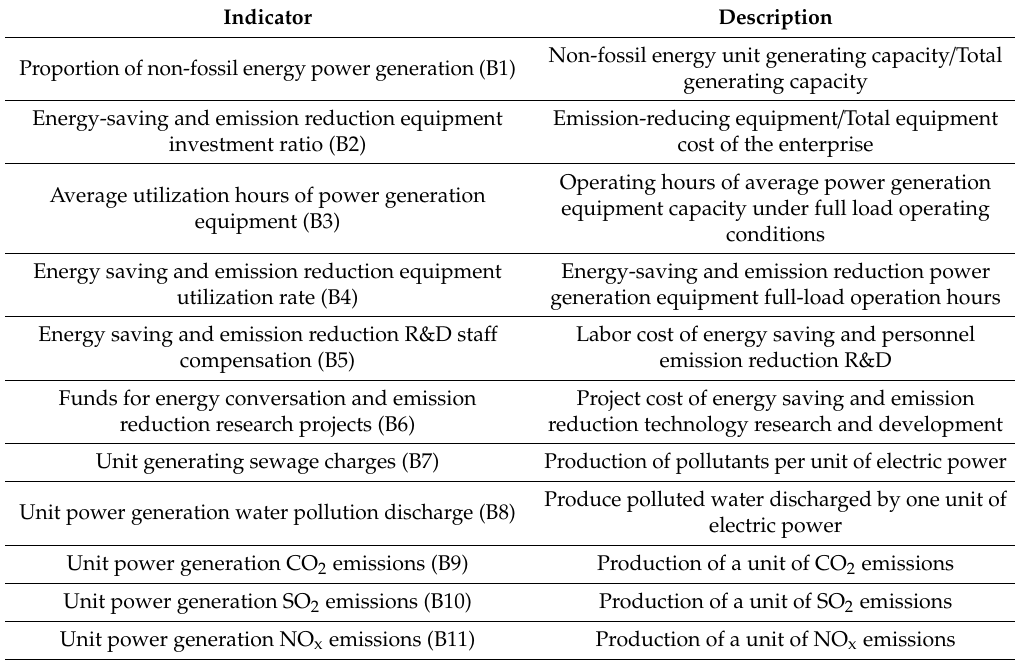
Table 2. Operational production